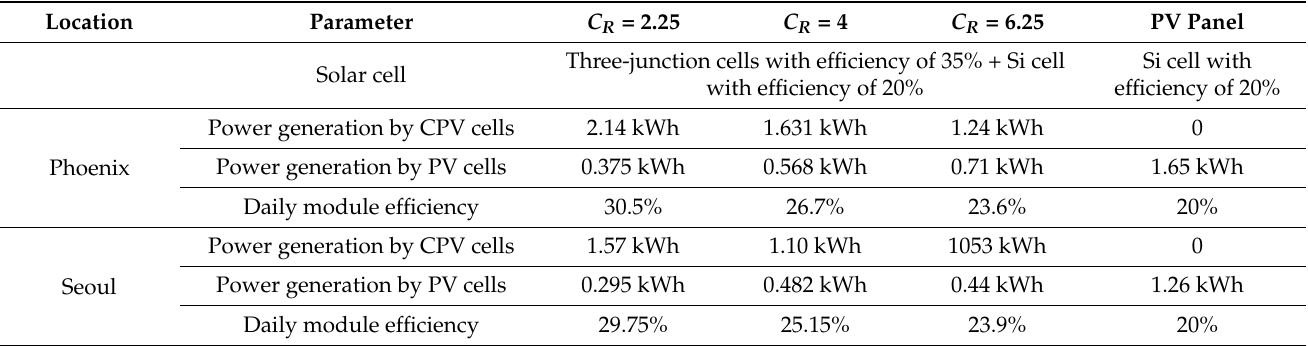
Table 2. Performance comparison among three types of static CPV modules and a conventional PV panel.